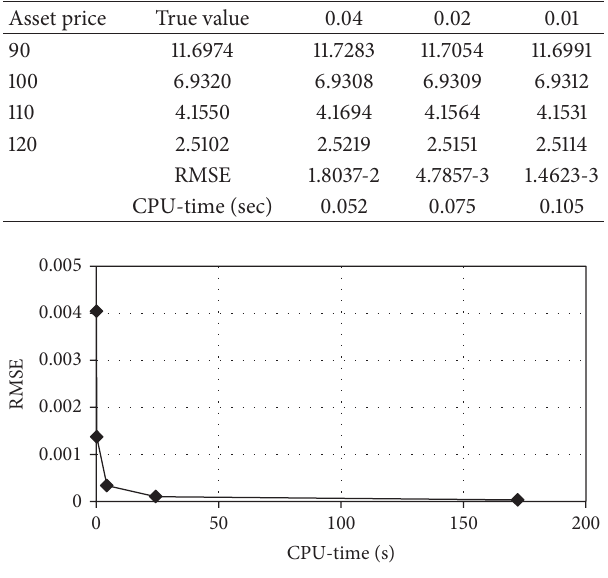
Figure 2: RMSE against the computational time.